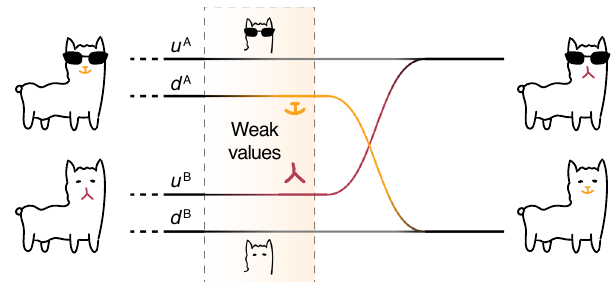
Fig. 1 Schematic illustration. A non-contacting grin exchange takes place between two quantum Cheshire cats. The cats Anna with sunglasses and Belle without sunglasses independently enter two bilayer channels, where the sundered grins from the cats can be revealed by their weak values. The structure of the channels is twisted so the two paths for Anna and Belle denoted by u and the two denoted by d ultimately join each other, respectively. Consequently, after exiting the setup, both cats are astonished to fi nd that they have swapped grins without having met each